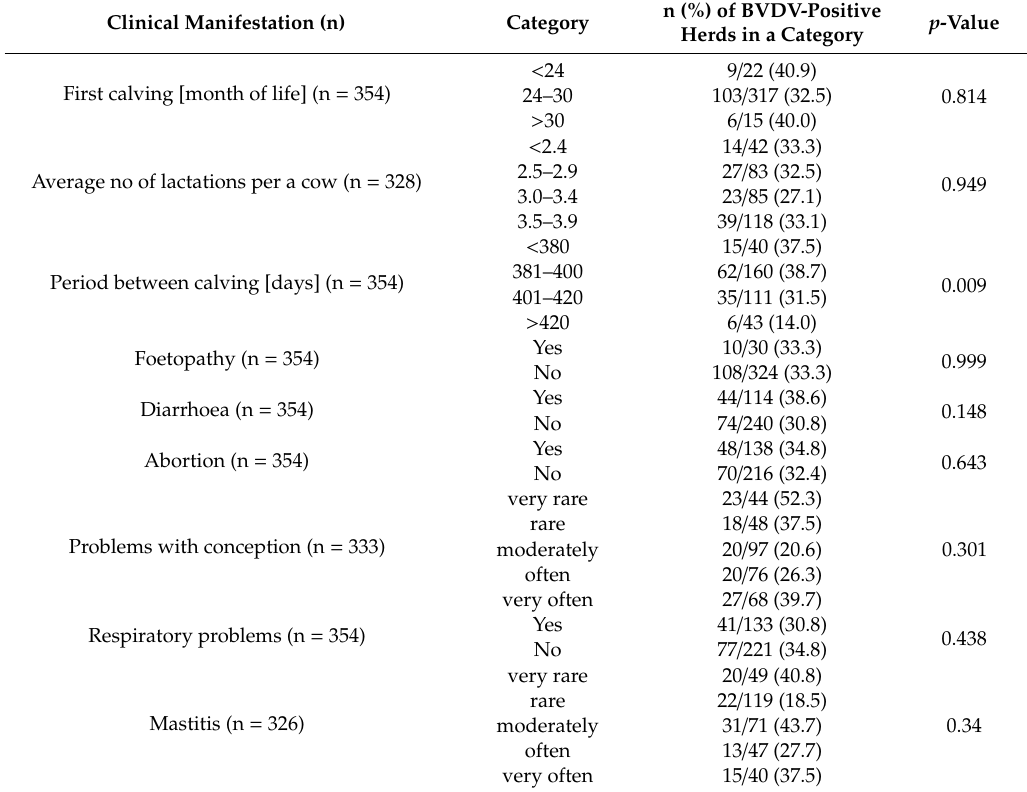
Table 4. Production and clinical outcomes potentially linked to the BVD infection at the herd